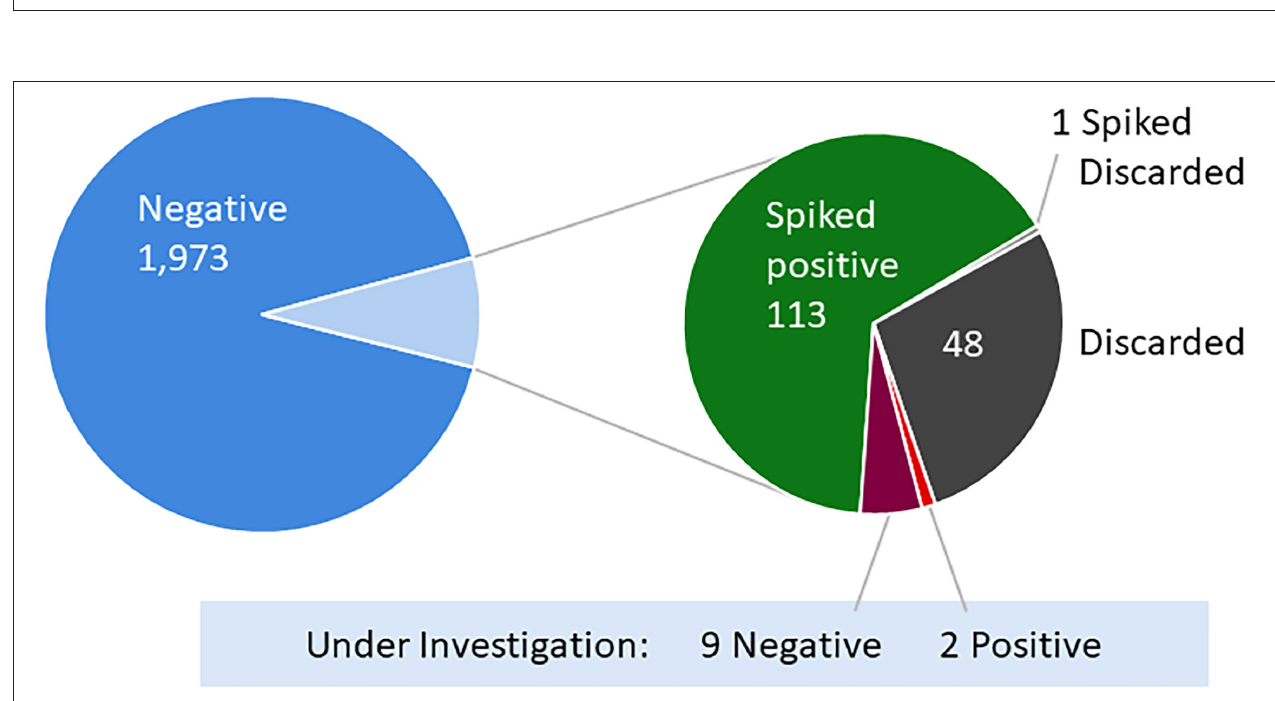
FIGURE 3 | Individual sample results of SARS-CoV-2 RT-PCR testing. Of the 2,032 community-sourced and 114 laboratory-generated pairs of samples, one sample from each pair was tested as an individual using the established SARS-CoV-2 RT-PCR testing protocol. Eleven of the sample pairs were collected from individuals under investigation and in quarantine due to possible exposure to SARS-CoV-2 (red and maroon).